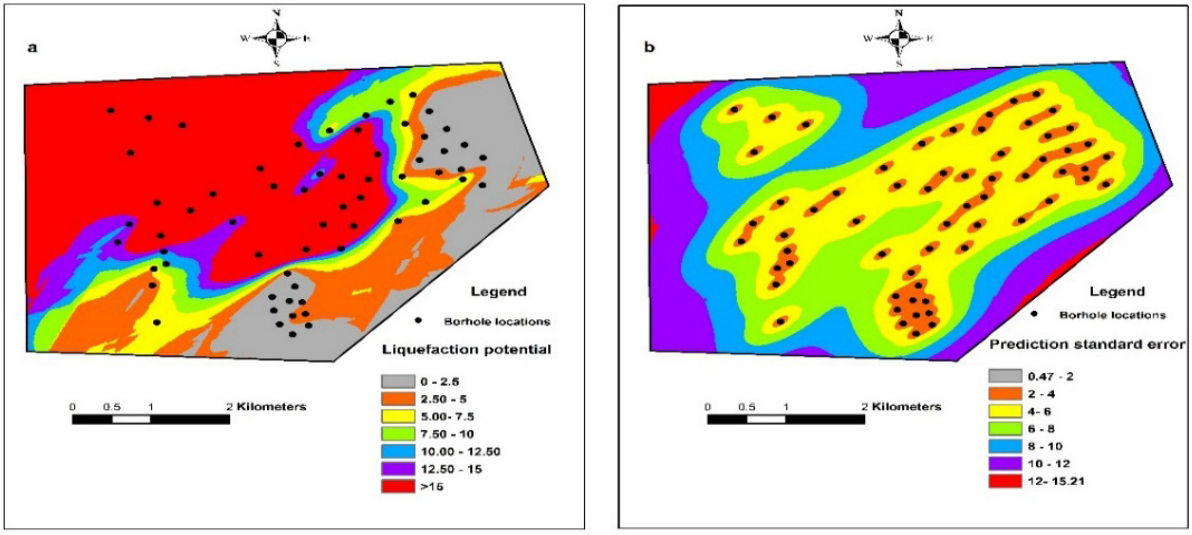
Figure 10: Liquefaction potential hazard map predicted by ordinary kriging (a) and corresponding standard deviation map (b) for earthquake magnitude of 6.8 and peak ground acceleration of 0.3 g (Anisotropic